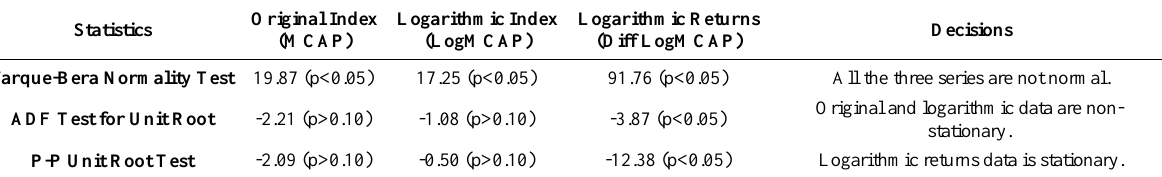
Table 1. The normality test and stationarity test of the three